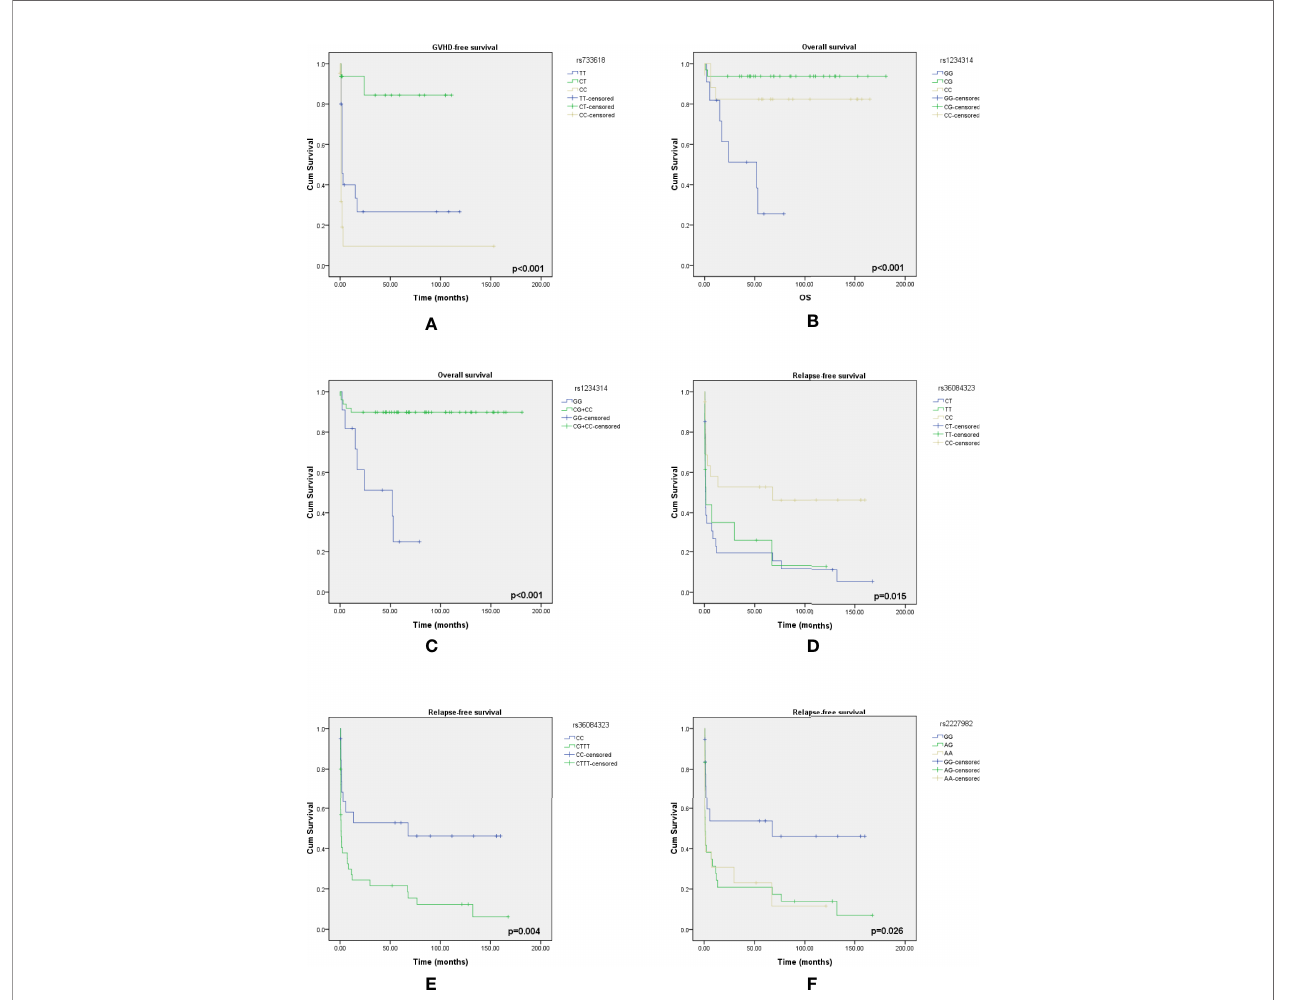
FIGURE 1 | Kaplan – Meier curves of overall survival with statistical signi fi cance based on the mortality-related SNPs and event-free survival based on the GVHD- related SNPs and relapse-related SNPs. (A) The survival time had a signi fi cant difference between the 3 genotypes of rs733618. (B) The survival time had a signi fi cant difference between the 3 genotypes of rs1234314. (C) The survival time had a signi fi cant difference between the 2 genotype groups of rs1234314. (D) The survival time had a signi fi cant difference between the 3 genotypes of rs36084323. (E) The survival time had a signi fi cant difference between the 2 genotype groups of rs36084323. (F) The survival time had a signi fi cant difference between the 3 genotypes of